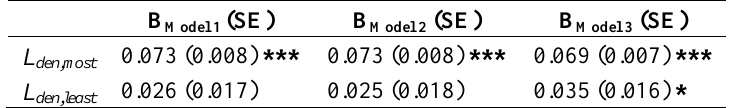
Table 3. Parameter estimates for L the linear regression model for annoyance score.